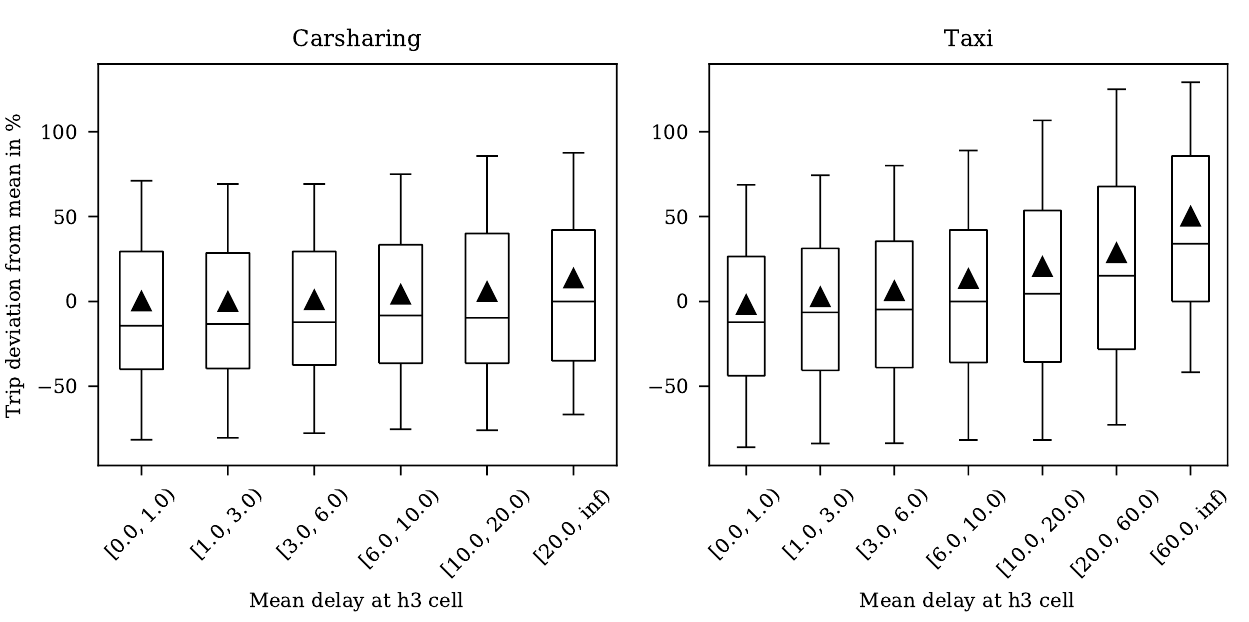
Figure 9. Increased Demand during